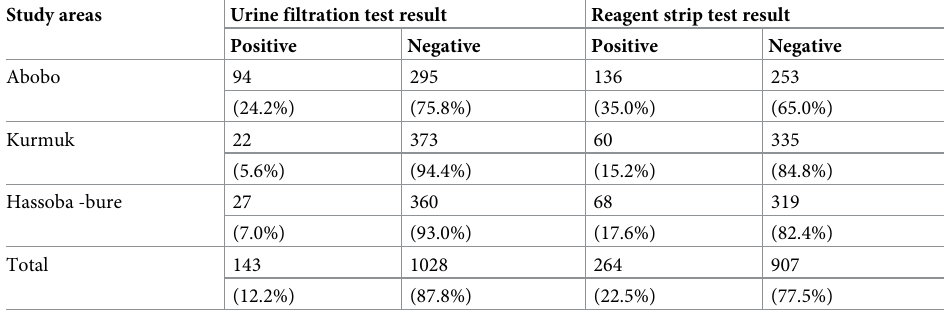
Table 2. Urogenital schistosomiasis prevalence by filtration method and urinalysis reagent strip test, Abobo, Has- soba and Kurmuk village, Ethiopia,